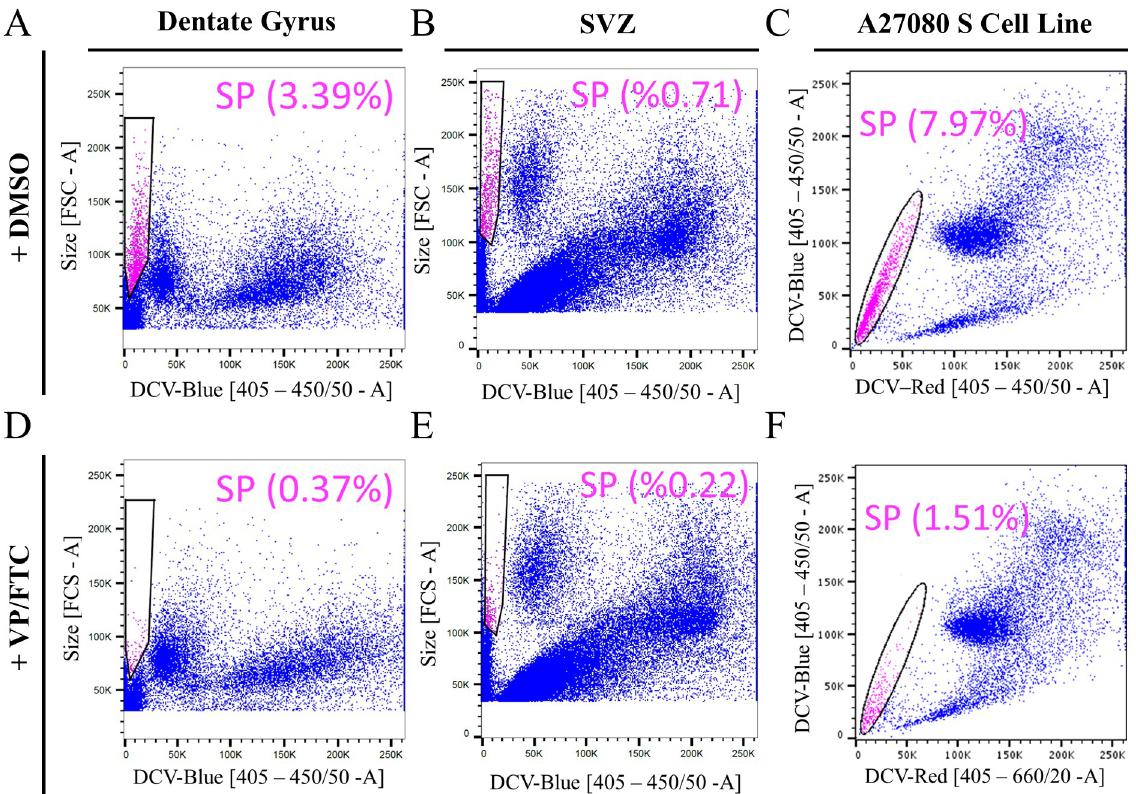
Fig 2. ABC transporter antagonists (VP and FTC) inhibit the side population phenotype of primary adult dentate gyrus and SVZ cells. Fluorescence/size plots for dentate gyrus (A) and SVZ (B) show the side population (SP, pink) and percentage of cells in the SP in the absence (A, B) and presence of VP and FTC (D, E) which significantly reduced the side population. A2780 S cell line, a positive control, shows a large side population in dual fluorescence plots (C) and nearly complete removal (F) of the effluxing side population by addition of inhibitors. Plots A and D are representative plots based on samples pooled from five male and three female mice. Plots B and E are representative plots based on samples pooled from six female